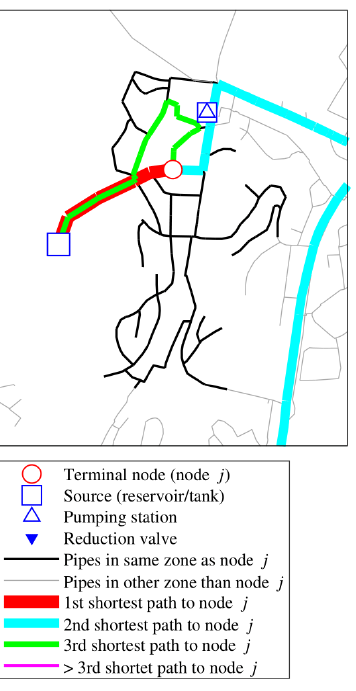
Figure 11. Example of the three shortest paths to a node in Trond- heim’s DWDS.